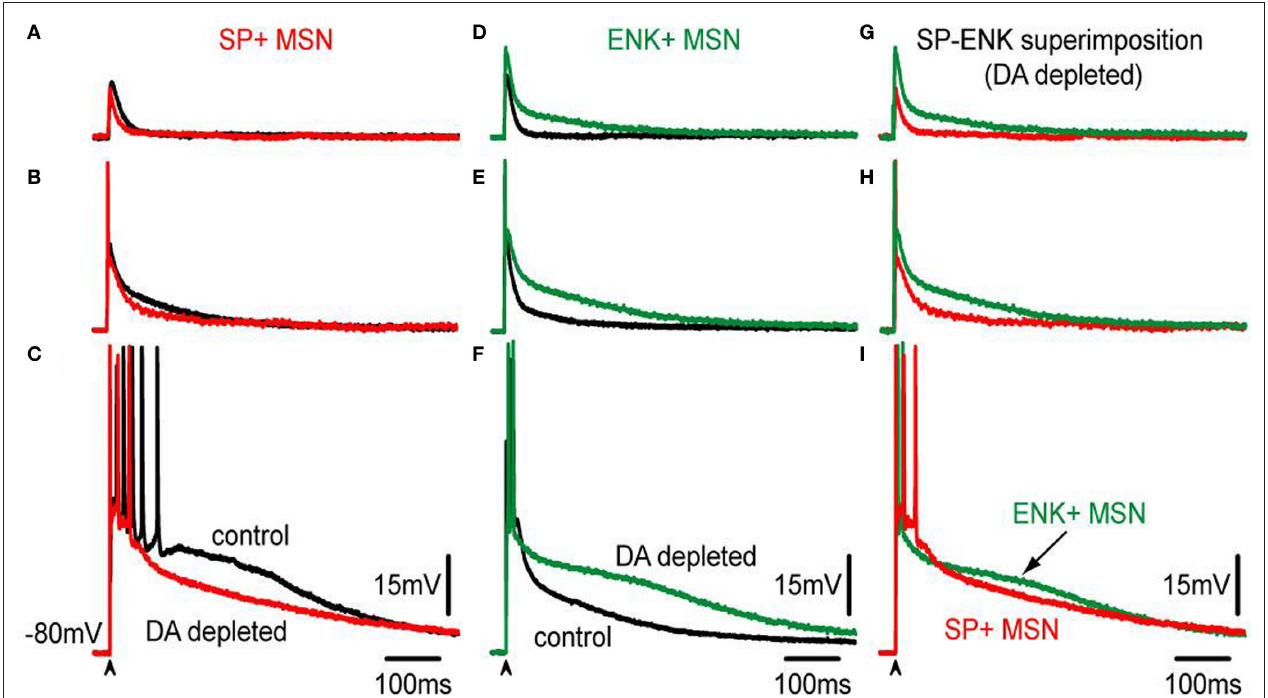
FiGure 6 | Comparison of corticostriatal responses evoked by different stimulus intensities in SP + and eNK + MSNs from intact and lesioned (6-OHDA) animals. (A–C) Superimposition of control, (black traces) and DA-depleted (red traces), subthreshold, threshold – spikes clipped – and suprathreshold corticostriatal responses in a representative SP + MSN. Except for the suprathreshold case, influence of DA depletion in the responses is hardly noticed. In the suprathreshold response depolarizing inhibition is decreased after DA depletion; similarly to the action of bicuculline